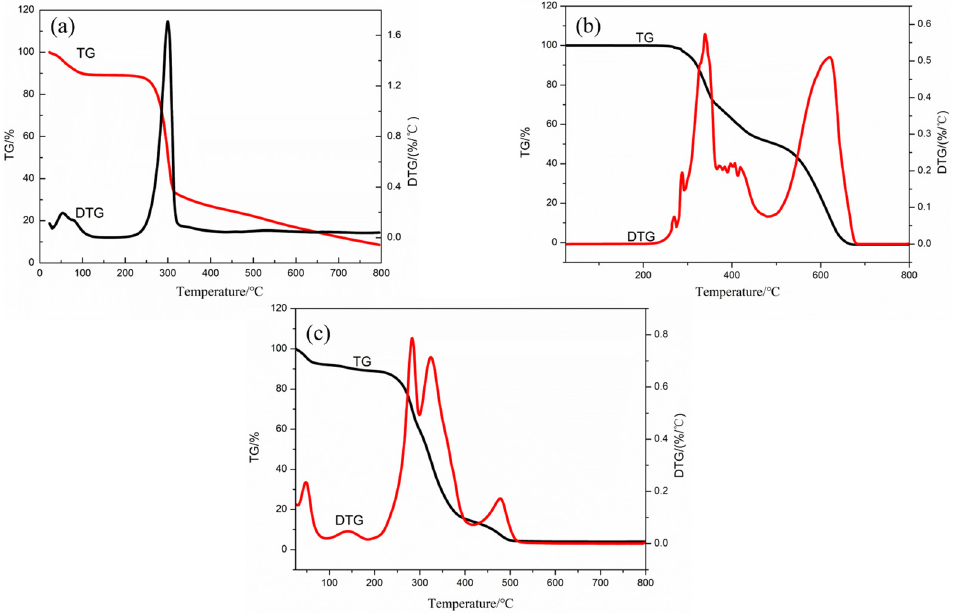
Figure 7. TG–DTG curves of BX, Res, and 3-CBA-BX/Res-g-EGDMA. ( a ) TG–DTG curve of BX. ( b ) TG–DTG curve of Res. ( c ) TG–DTG curve of 3-CBA-BX/Res-g-EGDMA.